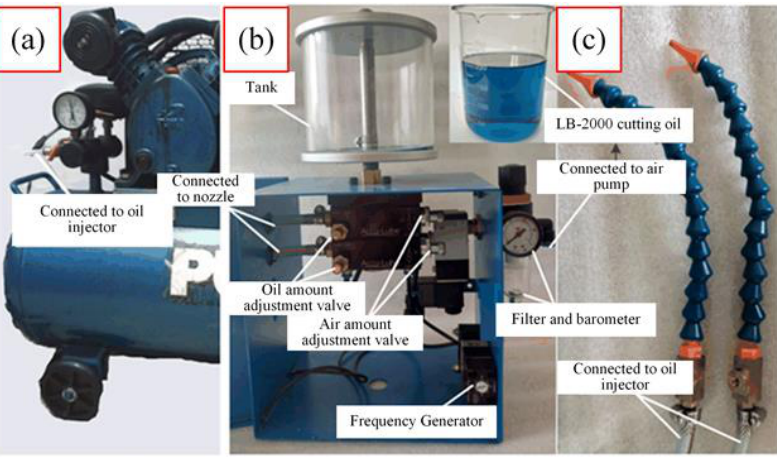
Figure 2. The MQL system: ( a ) air pump, ( b ) oil injector, and ( c ) nozzle.